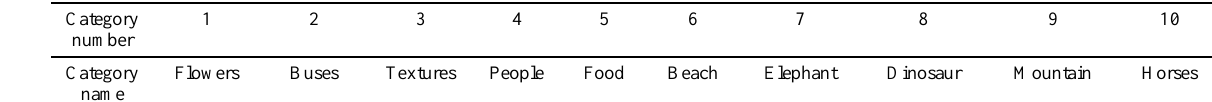
Figure 1. Image retrieval steps in the combined system. Table 1. Different categories of image database